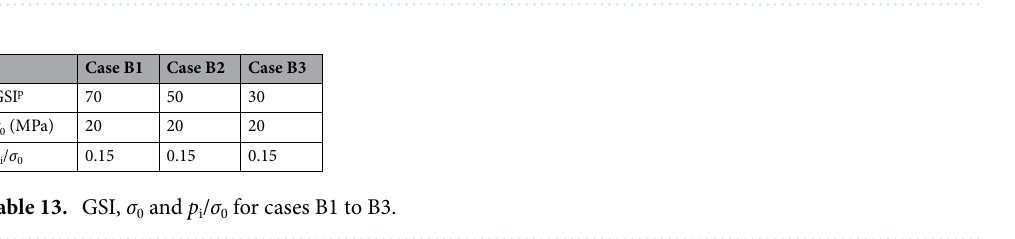
Figure 11. Sensitive analysis of GSI p , σ 0 and p i / σ 0 on ε θ : ( a ) cases B1; ( b ) case B2; ( c ) case B3.